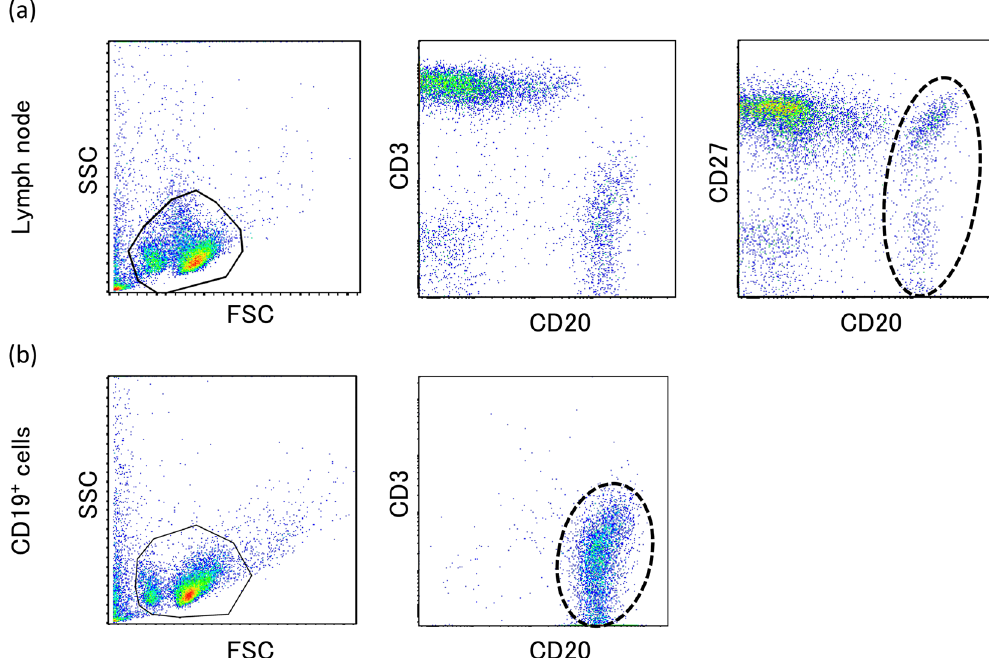
Figure 1. Cell surface antigen analysis by two-color flow cytometry. ( a ) Phenotype analysis of lymphocytes of the lymph node by flow cytometric analysis with a combination of anti-CD3/-CD20 and anti-CD27/-CD20 antibodies. B cells are surrounded by a dotted line. ( b ) Phenotype analysis of B cells purified using CD19- microbeads by flow cytomeric analysis with a combination of anti-CD3/-CD20 antibodies. Purified B cells are surrounded by a dotted